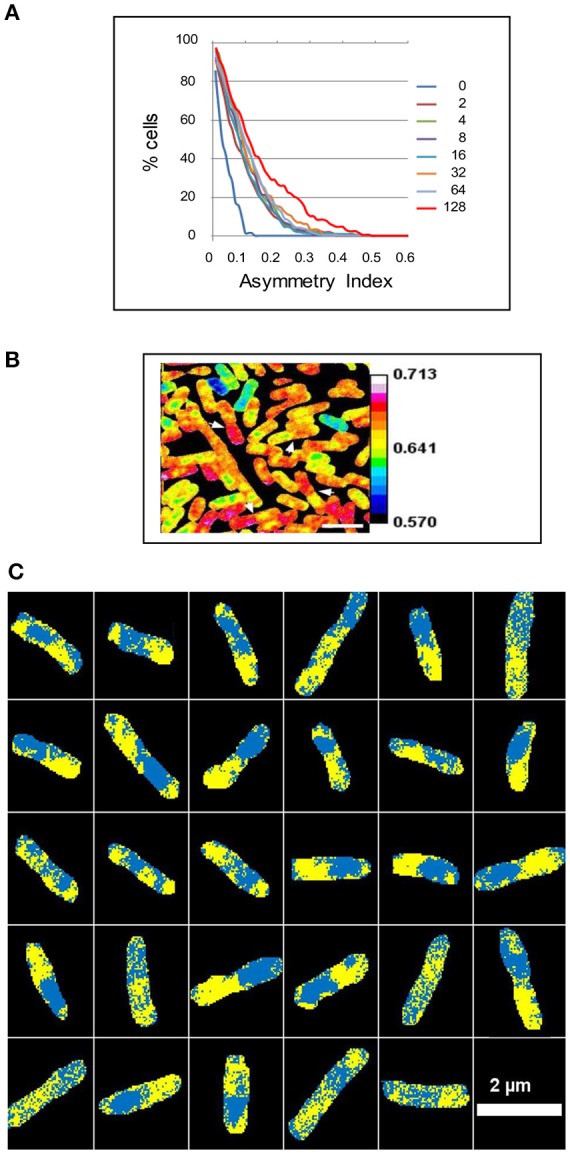
Intracellular asymmetry of isotope distribution in E. coli. A steady state culture was labeled with 15N for 2 to 128 min and analyzed using a NanoSIMS 50 to show the ratio of 12C15N/(12C14N+12C15N). (A) The cumulative percentage of cells 100*cP[Ia] above a given asymmetry index Ia in the A series. The median was taken for each cell and the asymmetry index then calculated as the proportion of pixels above the median in one half of the cell minus the proportion above the median in the other half of the cell (see Materials and Methods). (B) The white arrowheads show some daughter cells that have an asymmetric distribution of the isotope after labeling for 128 min. (C) The median was taken for each cell after labeling for 128 min and pixels above or below the median were colored yellow or cyan, respectively, to show 29 asymmetric cells within a sample of 111 cells. Scale bar 2 μm.